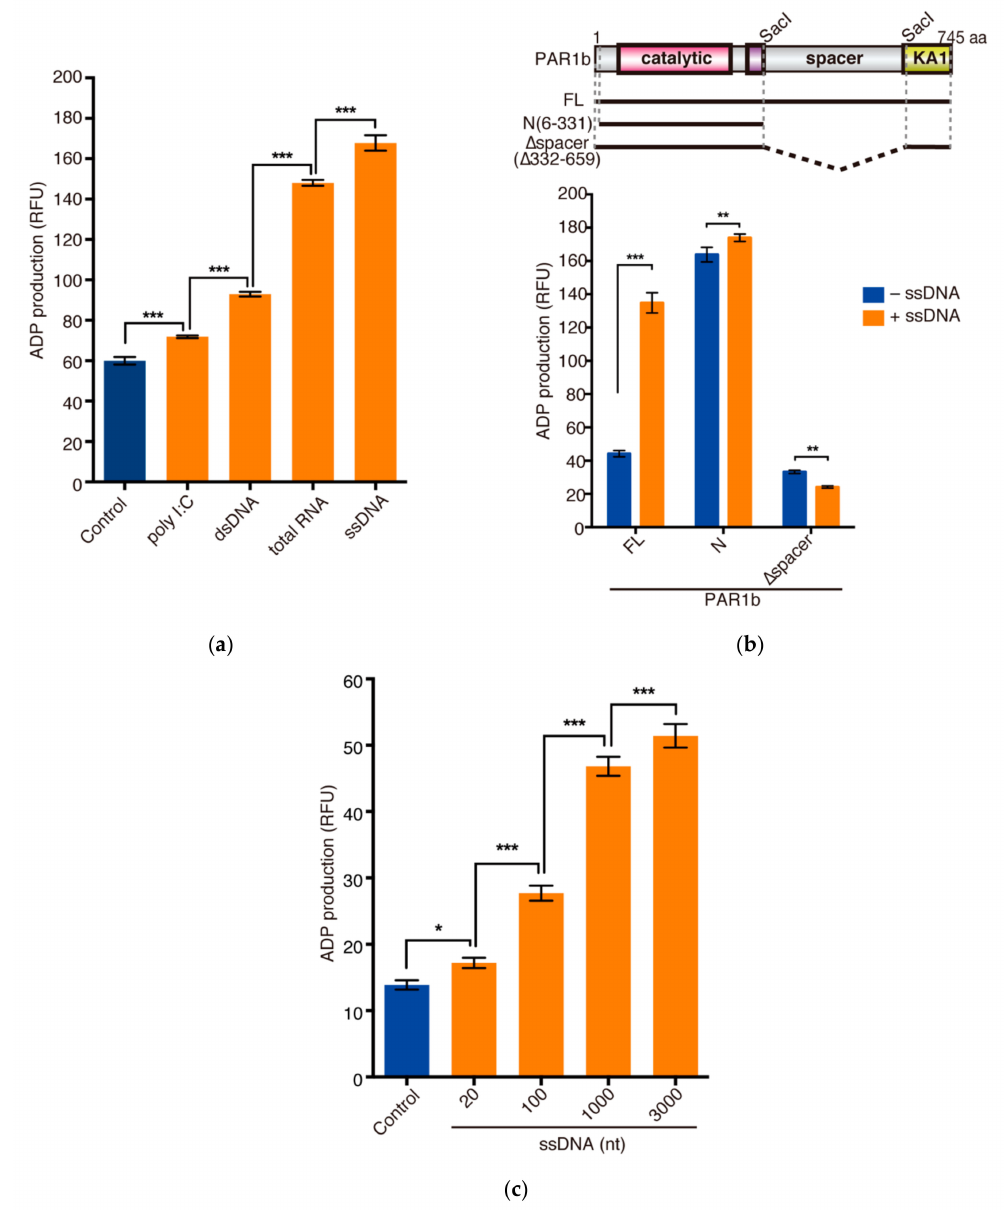
Figure 3. Nucleic acids enhance PAR1b kinase activity. ( a ) The effect of various nucleic acids on the kinase activity of recombinant PAR1b in an in vitro kinase assay. 200 nM PAR1b-FL was subjected to an in vitro kinase assay in the presence of 40 ng/ µ L nucleic acids as indicated. Total RNA, ssDNA, and dsDNA were purified from AGS cells. ( b ) The spacer region is required for the nucleic acid-dependent potentiation of PAR1b kinase activity. 200 nM of the mutant PAR1b proteins